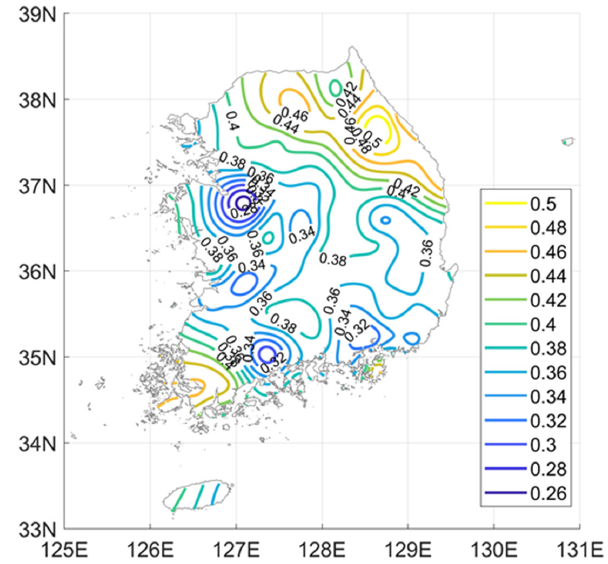
Figure 5. Contour map of the scaling exponent estimates for the AM series of South Korea.